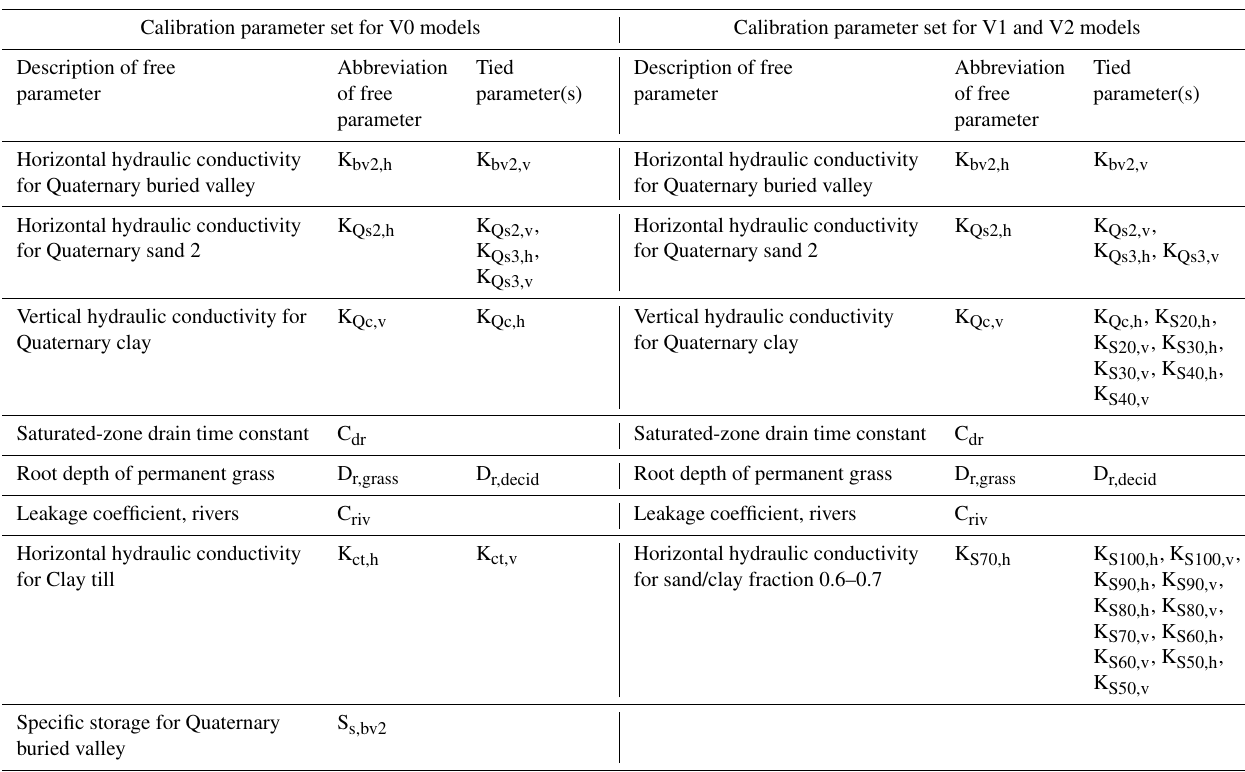
Table 4. Parameter sets for calibration, where h stands for horizontal, v stands for vertical, and S10–S100 stands for the sand/clay fraction classes, where, e.g., S100 is the sand/clay fraction of